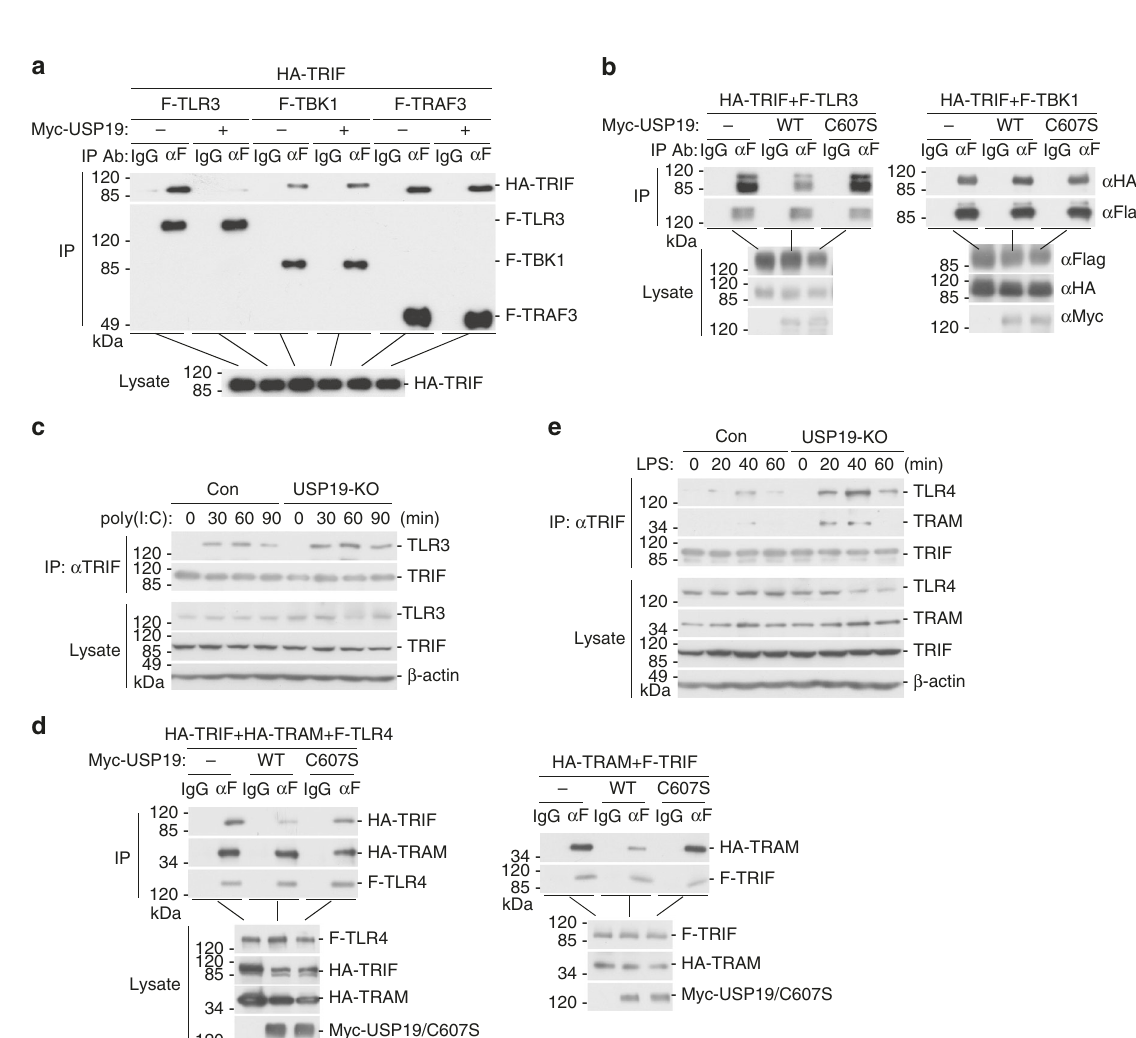
Fig. 6 USP19-mediated deubiquitination of TRIF impairs its function. a Overexpression of USP19 inhibits the interaction of TRIF with TLR3 but not with TBK1 or TRAF3. HEK293 cells were transfected with Flag-TLR3, Flag-TBK1, or Flag-TRAF3 and HA-TRIF together with a control or Myc-USP19 expression plasmid for 20 h. Coimmunoprecipitation was performed with anti-Flag or control IgG. The immunoprecipitates and lysates were analyzed by immunoblotting with anti-HA or anti-Flag. b Overexpression of USP19 but not USP19(C607S) inhibits TRIF-TLR3 interaction. HEK293 cells were transfected with Flag-TLR3 or Flag-TBK1 and HA-TRIF together with a control or Myc-USP19 expression plasmid for 20 h before co-immunoprecipitation and immunoblotting analysis with the indicated antibodies. c USP19-de fi ciency potentiates TLR3-TRIF association. The control or USP19-de fi cient 293- TLR3 cells were treated with poly(I:C) (100 μ g/ml) or left untreated for the indicated times. Cell lysates were immunoprecipitated with anti-TRIF or control IgG. The immunoprecipitates were analyzed by immunoblots with the indicated antibodies. d Overexpression of USP19 but not USP19(C607S) inhibits TRIF-TLR4 and TRIF-TRAM interactions. HEK293 cells were transfected with the indicated plasmids for 20 h before coimmunoprecipitation and immunoblotting analysis were performed with the indicated antibodies. e USP19-de fi ciency increases TLR4-TRIF association. The control or USP19- de fi cient 293-TLR4 cells were treated with LPS (100 ng/ml) or left untreated for the indicated times before coimmunoprecipitation and immunoblotting analysis with the indicated antibodies. Data are representative of three experiments with similar results. Source data are provided as a Source Data fi